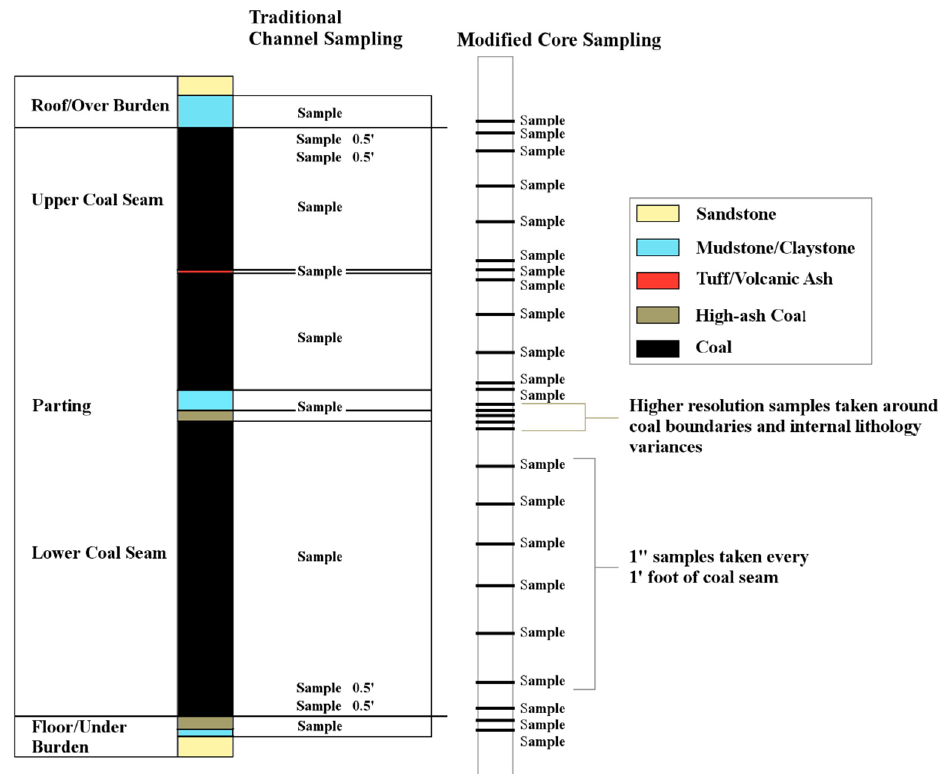
Figure 2. Example of sample spacing in coal core with sediment variances and expected REE and CM anomalies around those variances. Comparison is given to tradition channel sampling of the same stratigraphic sequence. Modified from CEGR sample plans provided by Coalgeo. LLC.